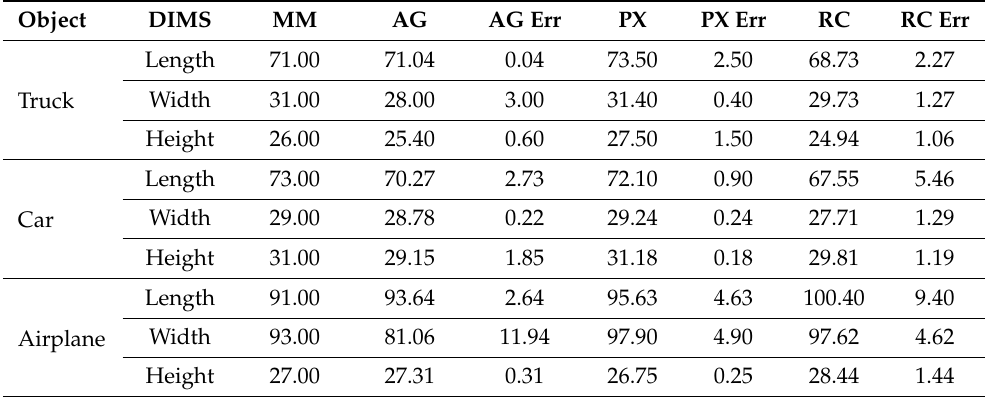
Table 3. Manual measurements (MM) of different dimensions (DIMS) against Agisoft (AG), Pix4d (Px), and RealityCatpure (RC) point clouds in millimeters.